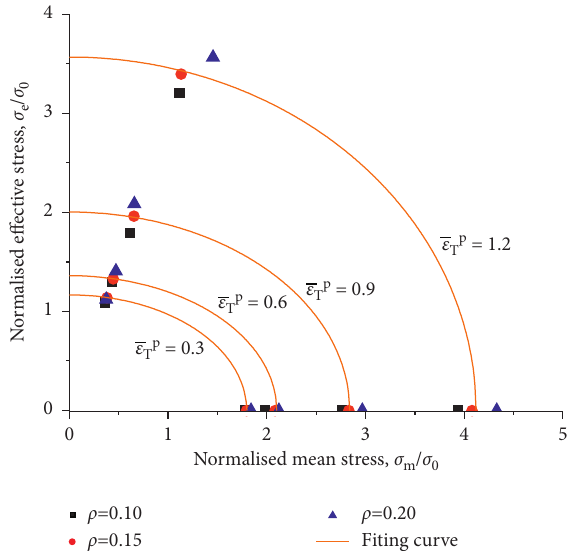
Figure 12: A schematic diagram of ellipse fittings for three relative density samples with the equivalent plastic strains of 0, 1.2, 1.7, and 2.0.